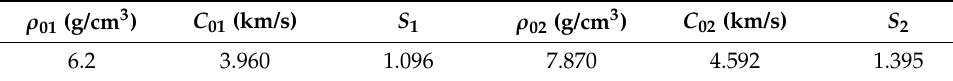
Table 3. The parameter data for calculation.